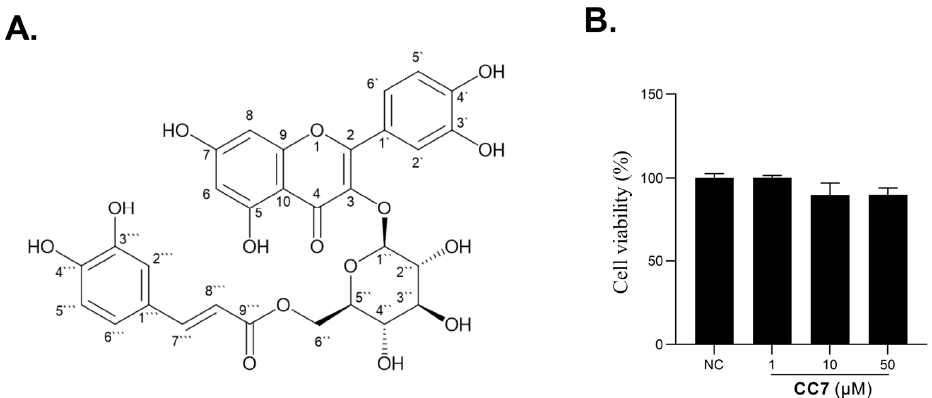
Figure 1. Toxicity test of the CC7 on B16 cells ( A ) Chemical structure of Quercetin 3-O-(6”-O-E- caffeoyl)- β -D-glucopyranoside ( CC7 ). ( B ) Effect of CC7 on B16 cell viability was measured using a CCK-8 assay kit. All results are represented as means ± SD of three independent experiments. Statistical chart expressed as a percentage relative to the negative control group.